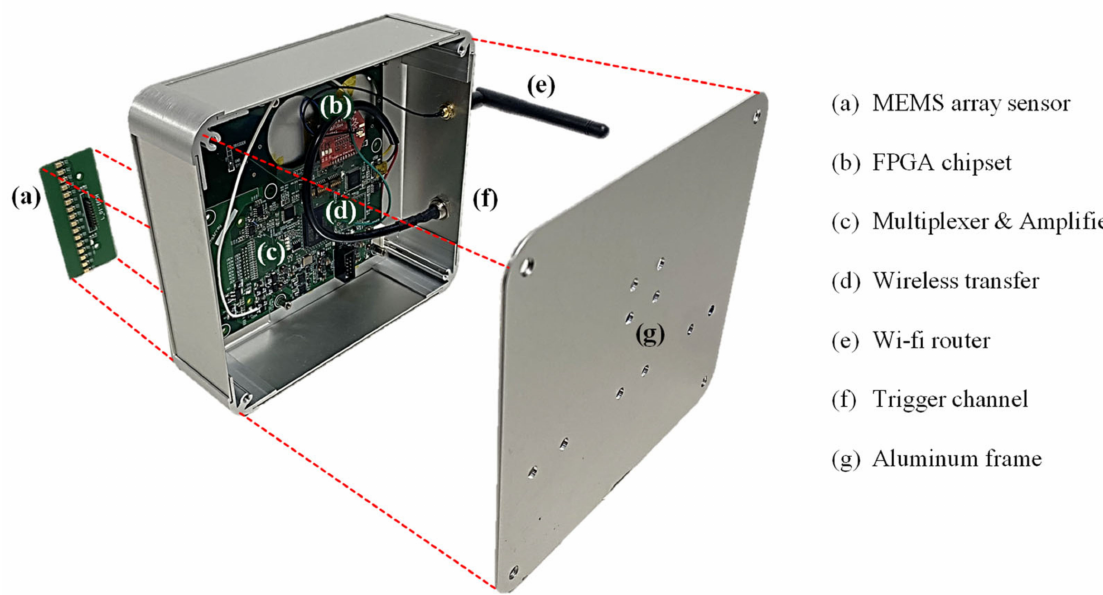
Figure 3. The developed wireless and contactless ultrasonic measurement